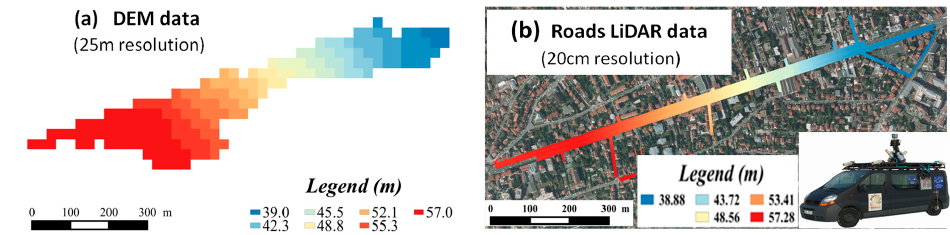
Figure 3. Different sources of the topographic data. ( a ) Coarse digital terrain model (DTM) data of 25 m resolution; ( b ) 20 cm resolution light detection and ranging (LiDAR) topographic data for roads and sidewalks.